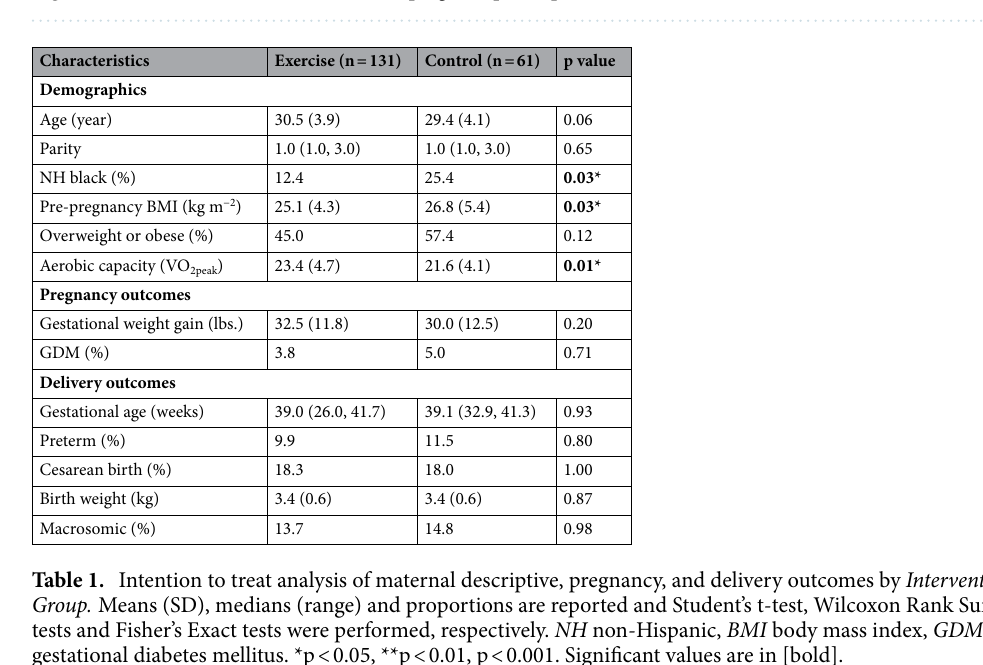
Figure 1. Recruitment and enrollment of pregnant participants.